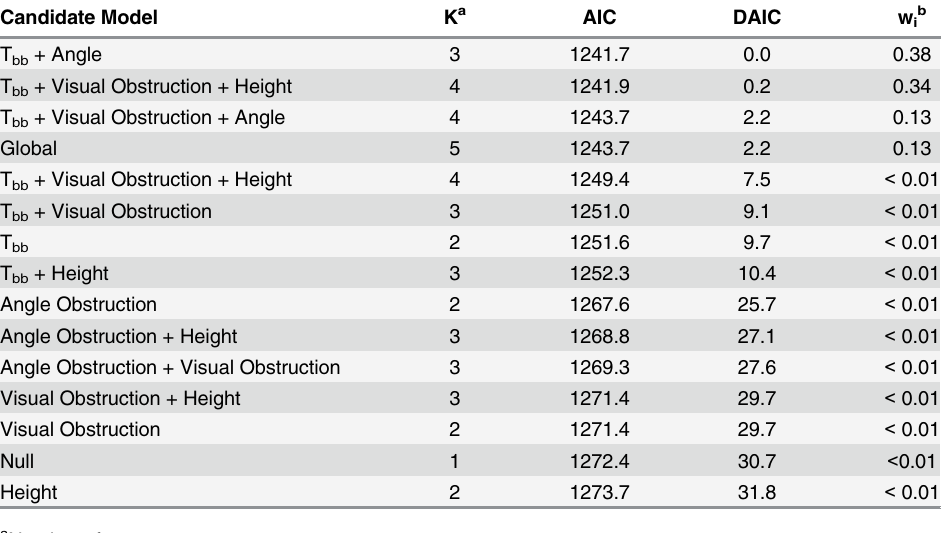
Table 2. Logistic regression candidate model rankings for variables affecting northern bobwhite nest success at the Packsaddle WMA, Oklahoma, USA (2013 – 2014). Black bulb temperature (i.e., T bb ), angle of obstruction, visual obstruction, and vegetation height (i.e., height) were variables included in candidate models. Candidate Model K